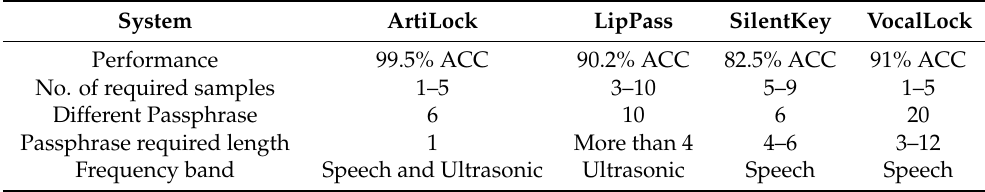
Table 2. Comparison with other articulation-based authentication systems.